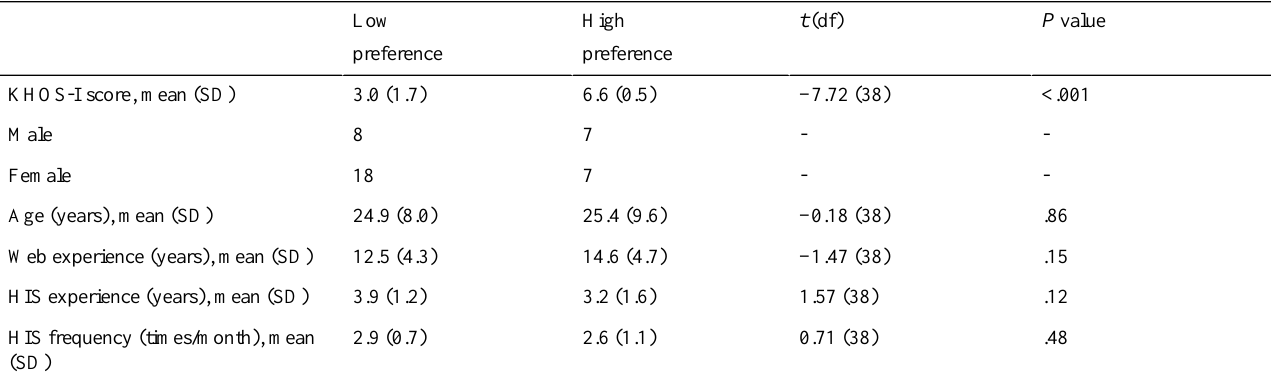
Table 2. Demographics and health information search (HIS) experience by preference for information.